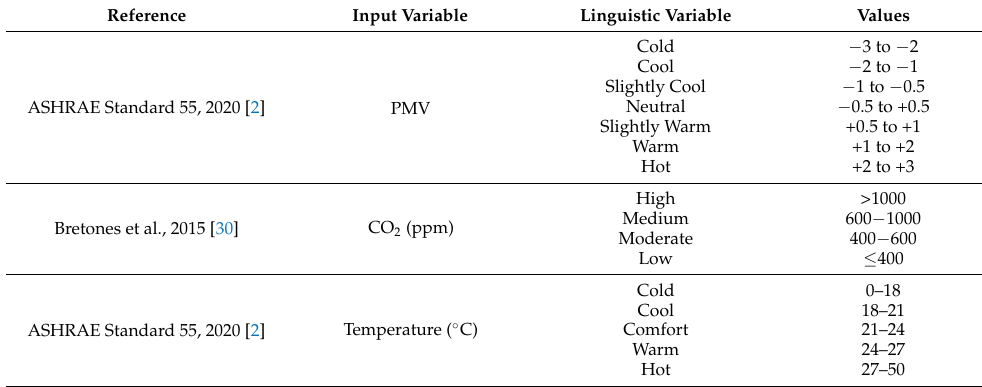
Table 3. Fuzzy controller input linguistic values that are used by the membership function.